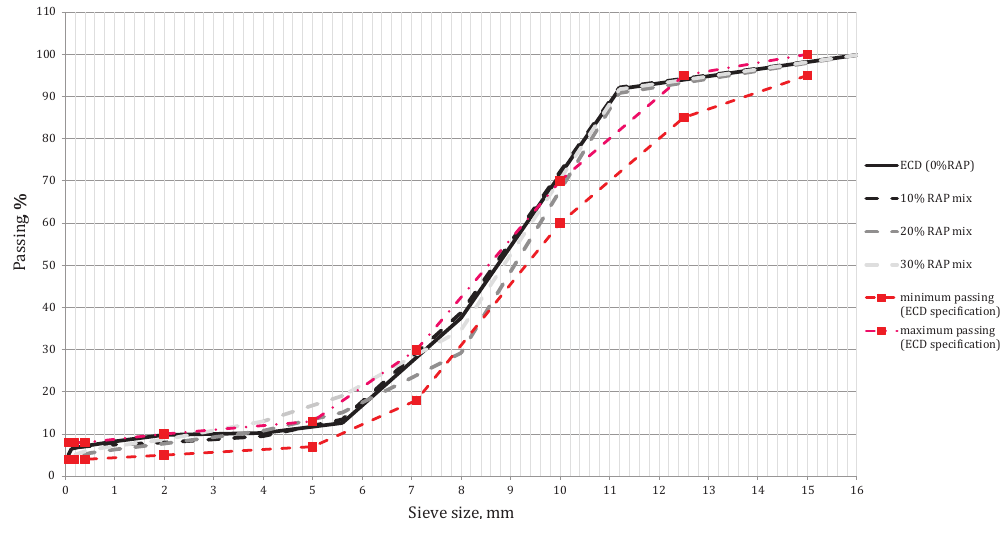
Figure 1. Mixture gradation